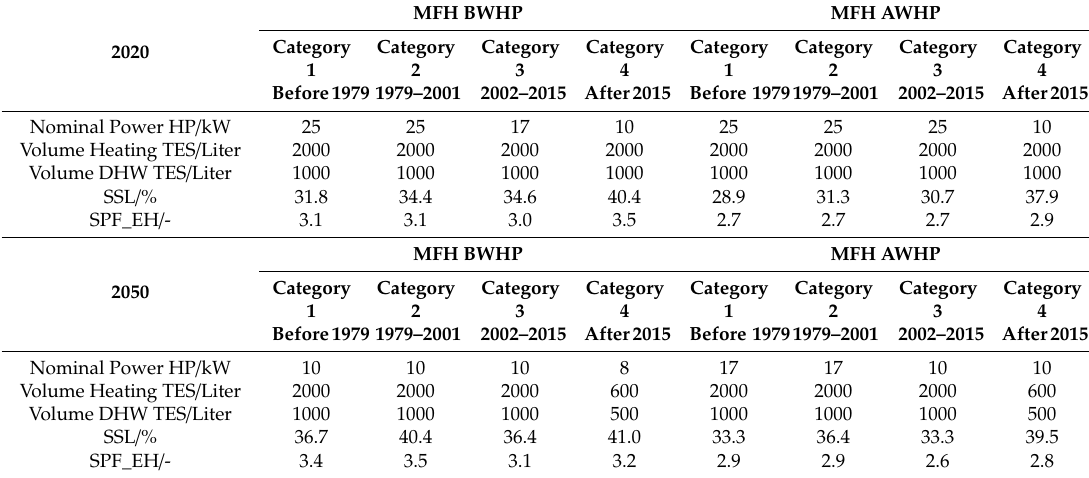
Table 2. Summary of simulation results for MFH reference buildings for BWHP and AWHP as well as for 2020 and